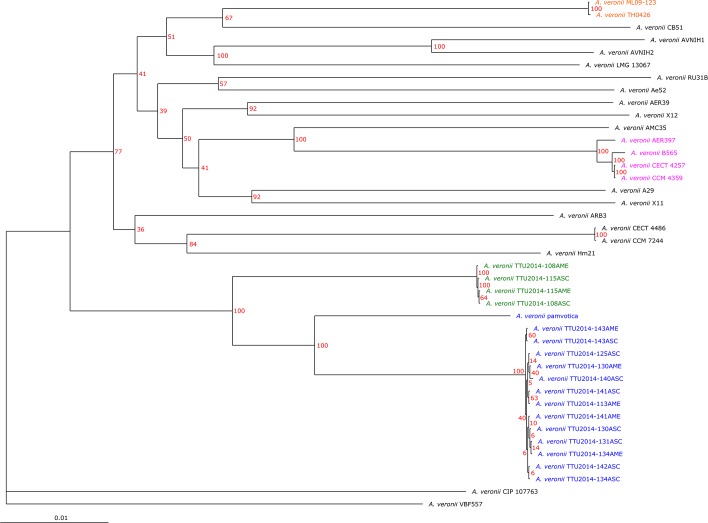
Maximum likelihood phylogeny created with RAxML.Branch labels show the branch conservation in percent of 100 rapid bootstrapping iterations. The four conserved subgroups are highlighted. The bootstrap support within the cluster of U.S. dairy cattle isolates is in part very low, most likely due to the extremely high conservation among these strains, but the separation of this cluster from the rest of the tree is very well conserved.